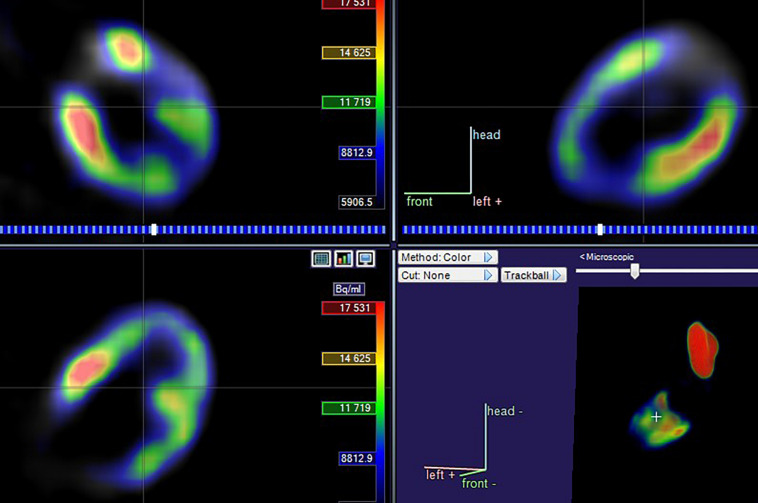
Planes of myocardial PET imaging.